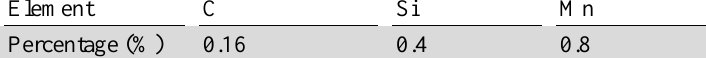
Chemical composition of workpiece material (MS)